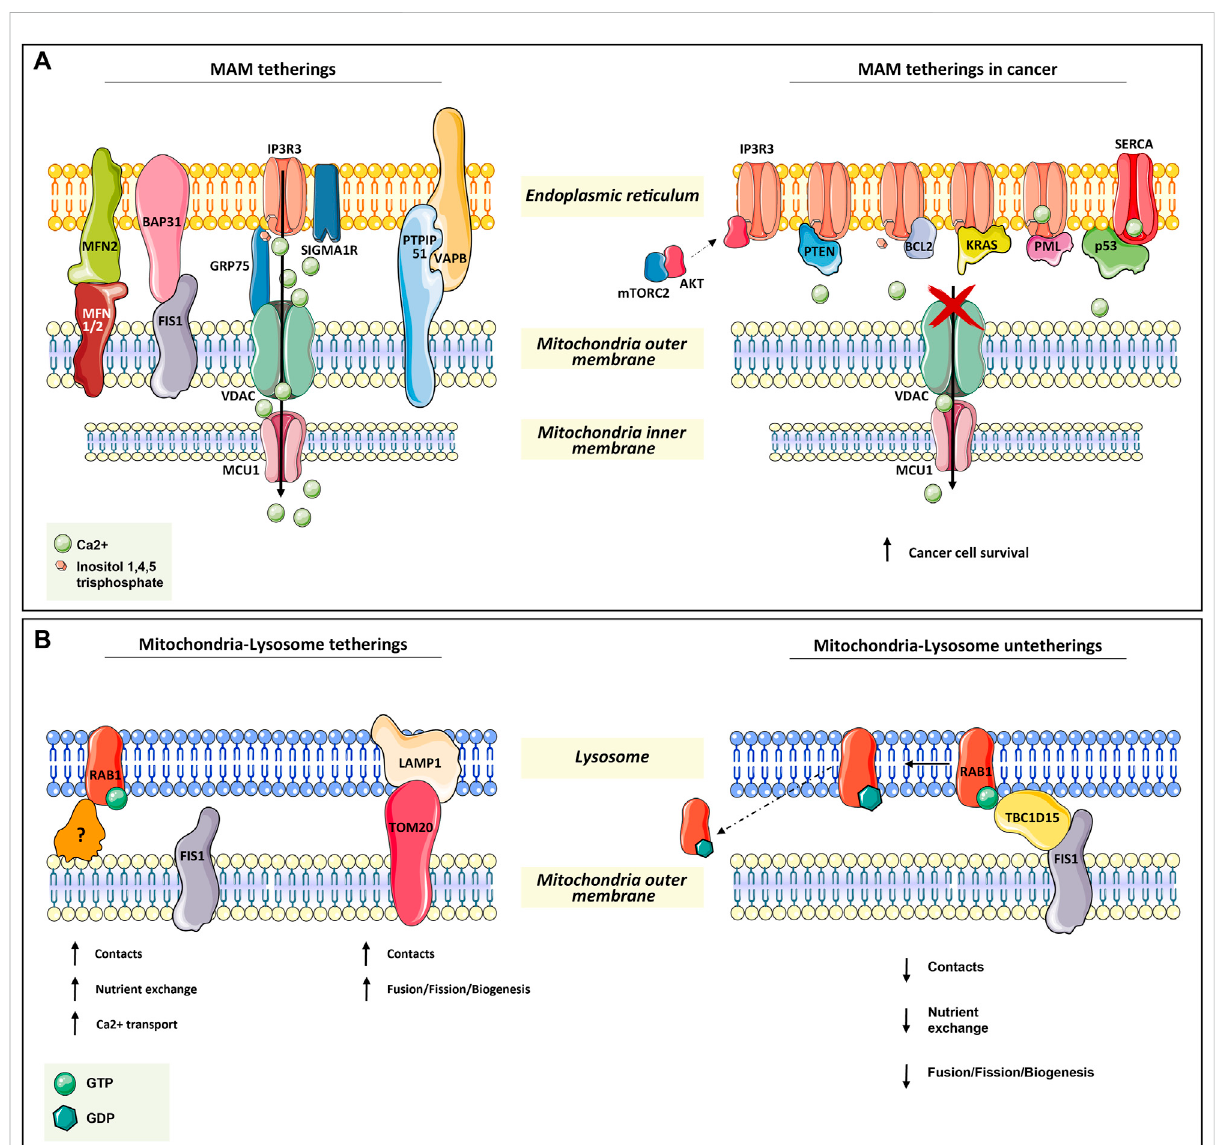
FIGURE 1 Mitochondria tetherings with ER and lysosomes. (A) Mitochondria – ER tethering systems, named mitochondria – ER-associated membranes (MAMs). In the left panel, the architectural and functional systems for mitochondria – ER association are described. Notably, the IP3R3/sigma1R- GRP75-VDAC1-MCU1 axis is both fundamental for membrane proximity and association while being functional for Ca 2+ homeostasis regulation, as for the other systems in the fi gure (read Section 2.1). On the right panel, the proteins found transiently located at MAM are depicted. All of them (oncogenes or onco-suppressors) regulated cancer progression through IP3R3 and SERCA, thus acting on mitochondrial Ca 2+ homeostasis. (B) In the left panel, the functional tethering between mitochondria and lysosome for proper nutrient exchange, Ca 2+ homeostasis, and mitochondria dynamics(fusion, fi ssion,biogenesis).Intherightpanel,themolecularmechanisminvolvedinmitochondria – lysosometetheringdisruption,whichis mediated by TBC1D15 on RAB1-GTPase, is depicted (read Section 2.2 for more